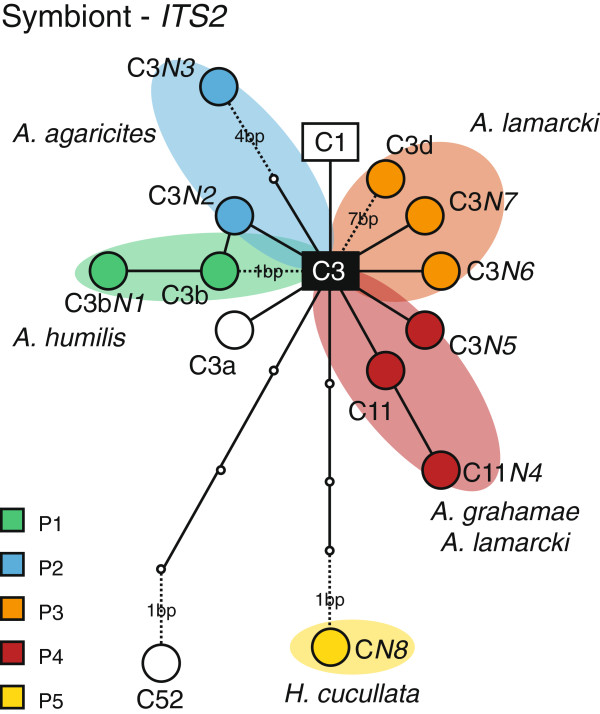
Sequence network of Symbiodinium ITS2 types observed for each DGGE profile obtained from agariciid species. Ancestral Symbiodinium types C1 and C3 are represented by squares. Circle size is not representative of frequency. Dashed lines indicate sequence gaps (with gap size in number of base pairs). Colours group the different ITS2 sequences observed in each DGGE profile. The C3 type (indicated by black square) is found in all DGGE profiles except for P5.